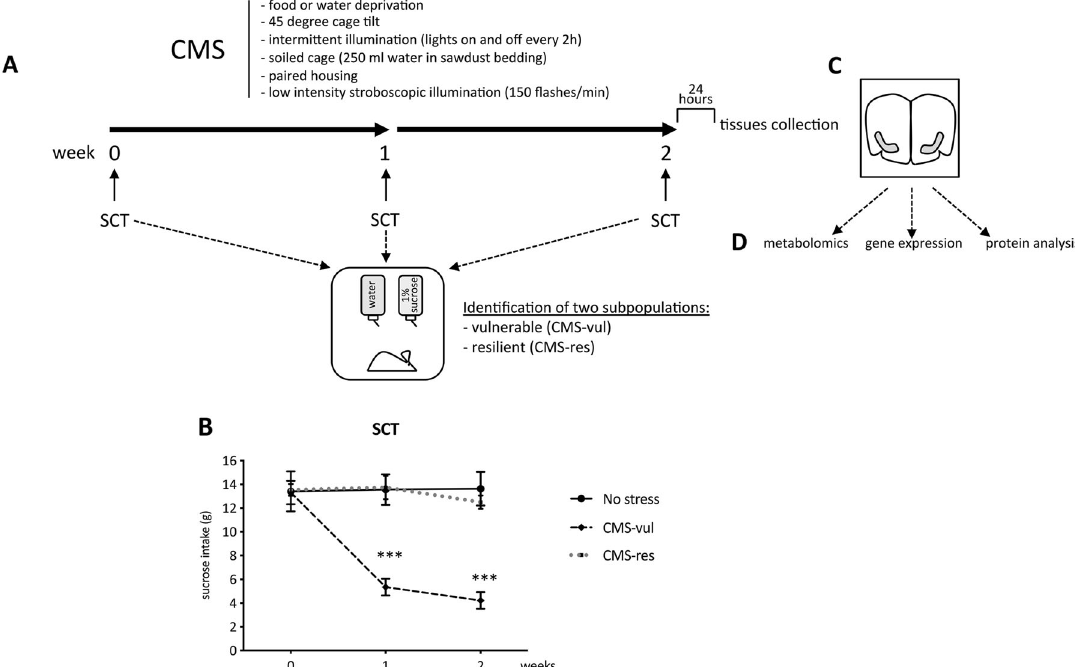
Fig. 1 Behavioral characterization of animals exposed to chronic mild stress. A schematic representation of the experimental paradigm; B sucrose intake was measured in the sucrose consumption test (SCT) at weekly intervals in control (no stress) or stressed (CMS-vul/CMS-res) animals. The data are the mean ± SEM: *** P < 0.001 vs no stress (one-way ANOVA with repeated measures, Fisher ’ s PLSD); C schematic representation of the dissection of the vHip; D analysis performed in